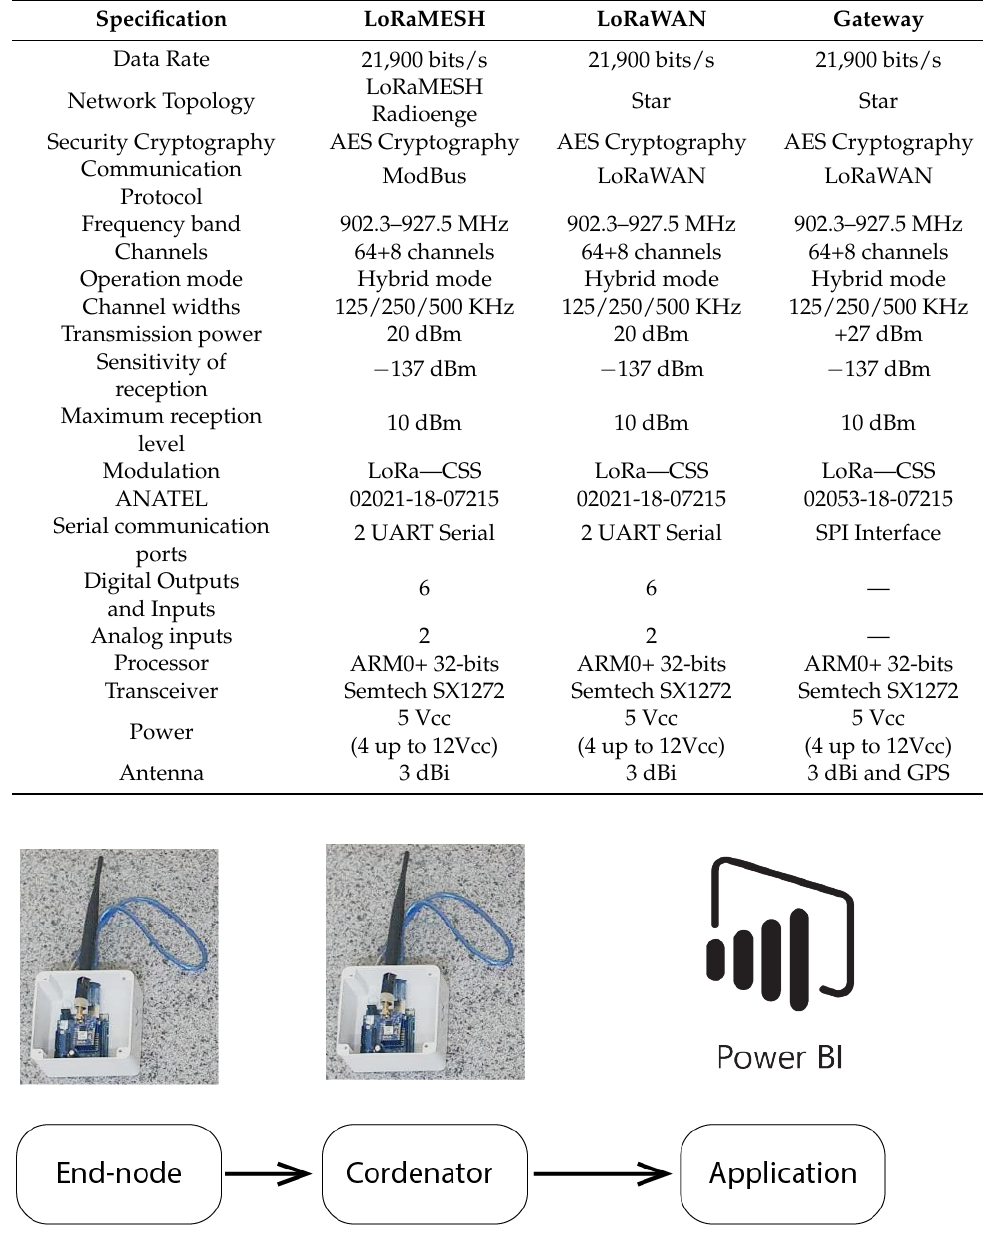
Table 2. LoRa Radioenge end-node specifications.